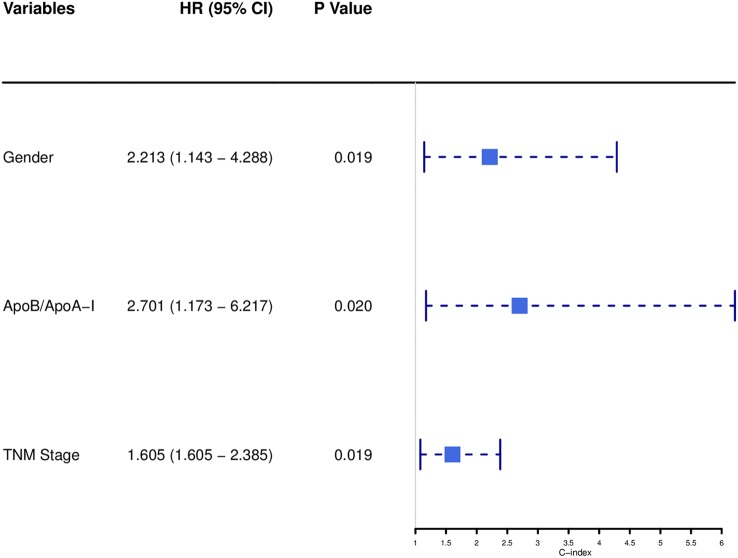
Forest plot showed the hazard ratio and 95% confidence interval for OS according to the Cox proportional hazards regression analysis in SCCE patients.